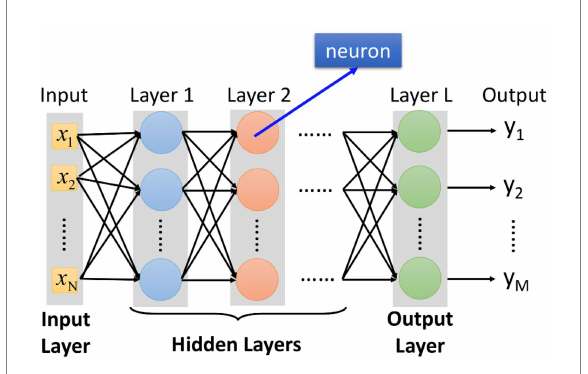
FIGURE 1 Model diagram of deep learning